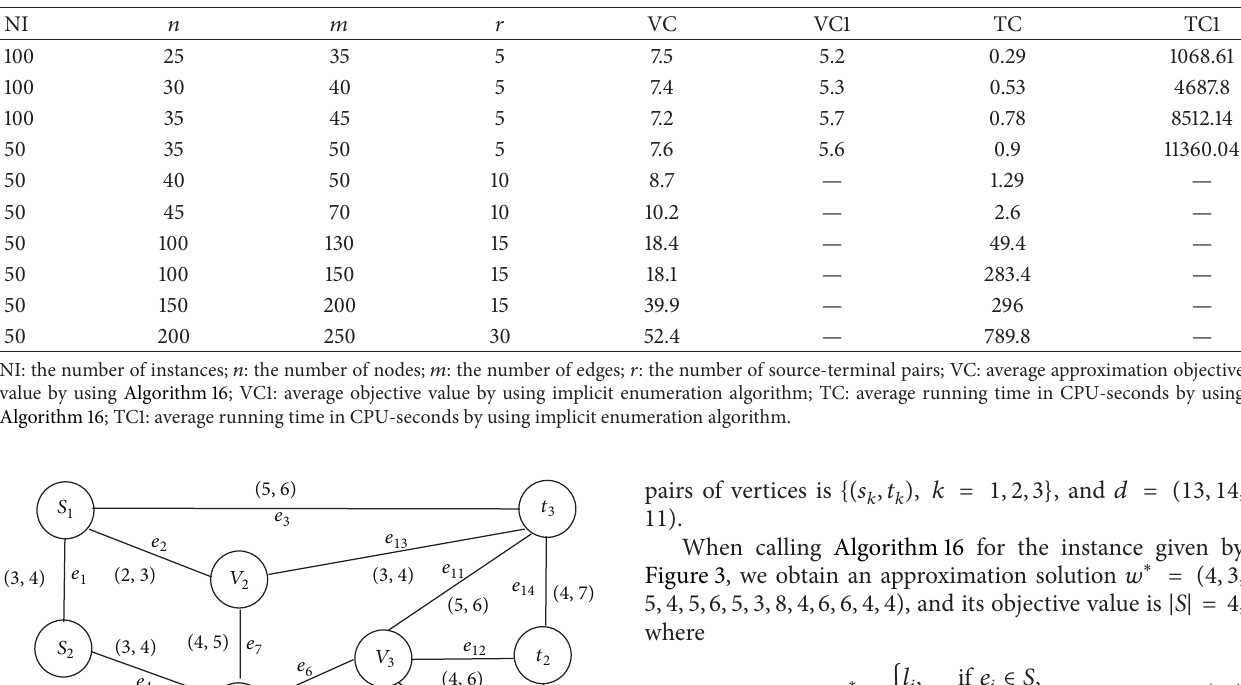
Table 2: Computational results of the Algorithm 16 and that of implicit enumeration algorithm.